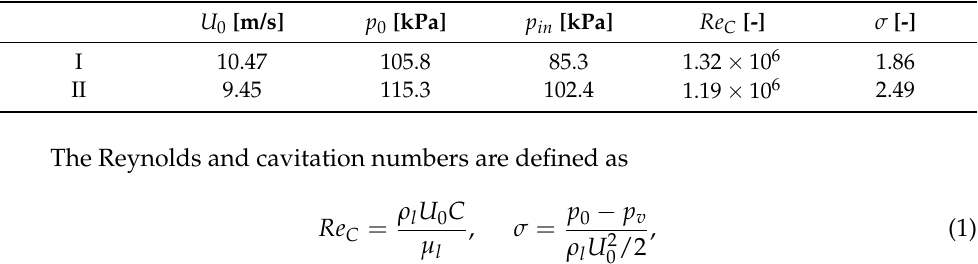
Table 1. Flow regimes considered in present